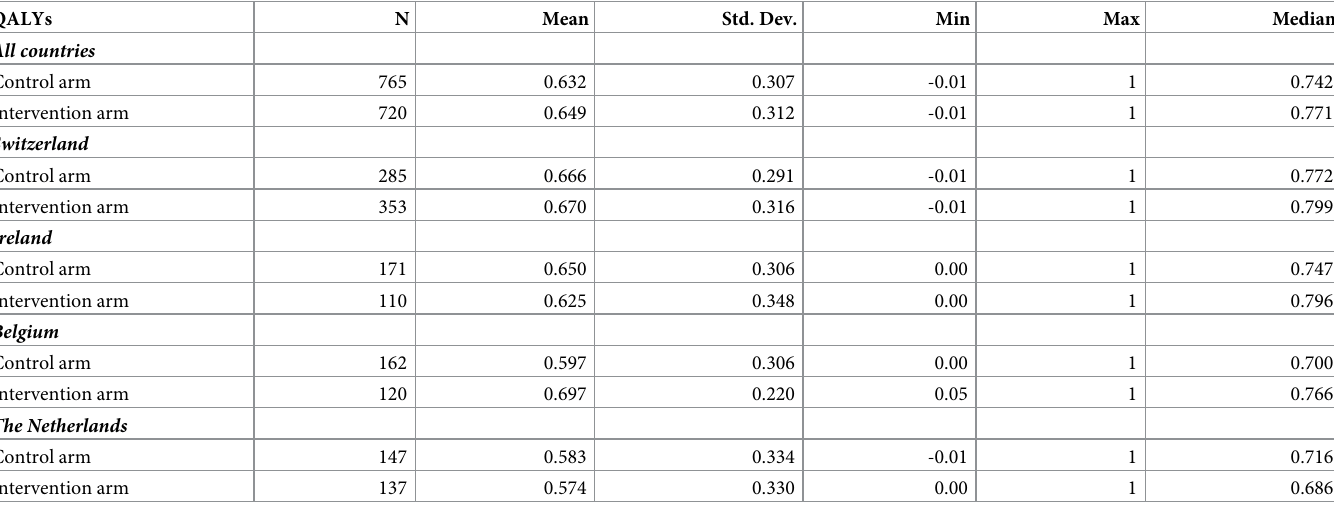
Table 1. QALYs for all countries and by country per patient over one